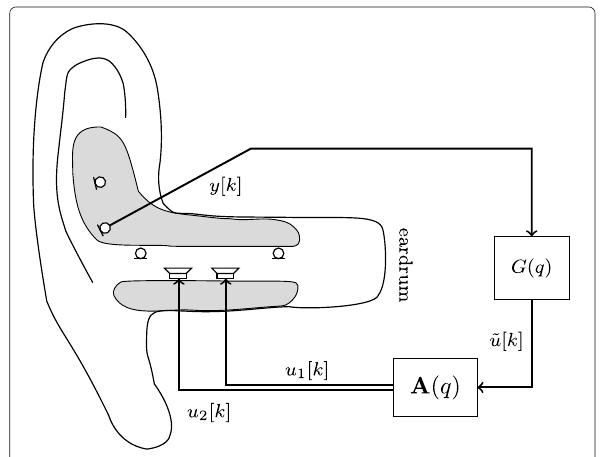
Fig. 1 Schematic overview of considered single-microphone multi-loudspeaker earpiece setup